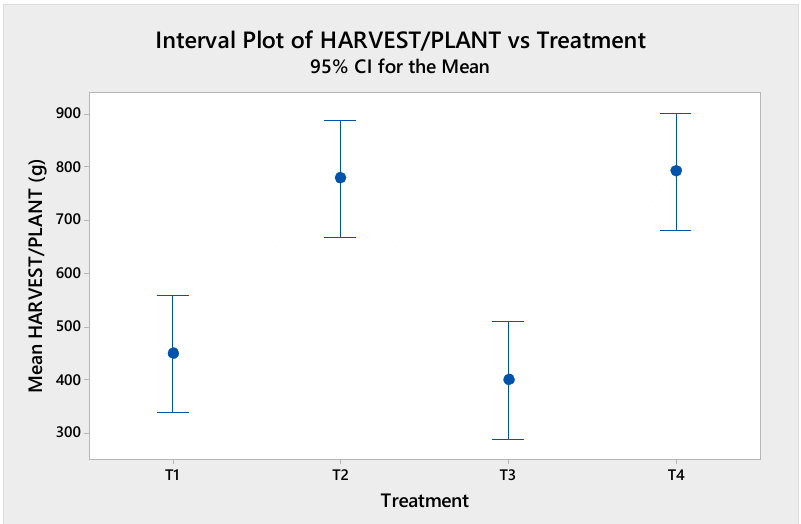
Figure 4. Interval plot of “harvest/plant” between different treatments. Bars express a 95% confidence interval. T1: without mulch + 251 mm of water; T2: with mulch + 251 mm of water; T3 without mulch + 129 mm of water; T4: with mulch + 129 mm of water.